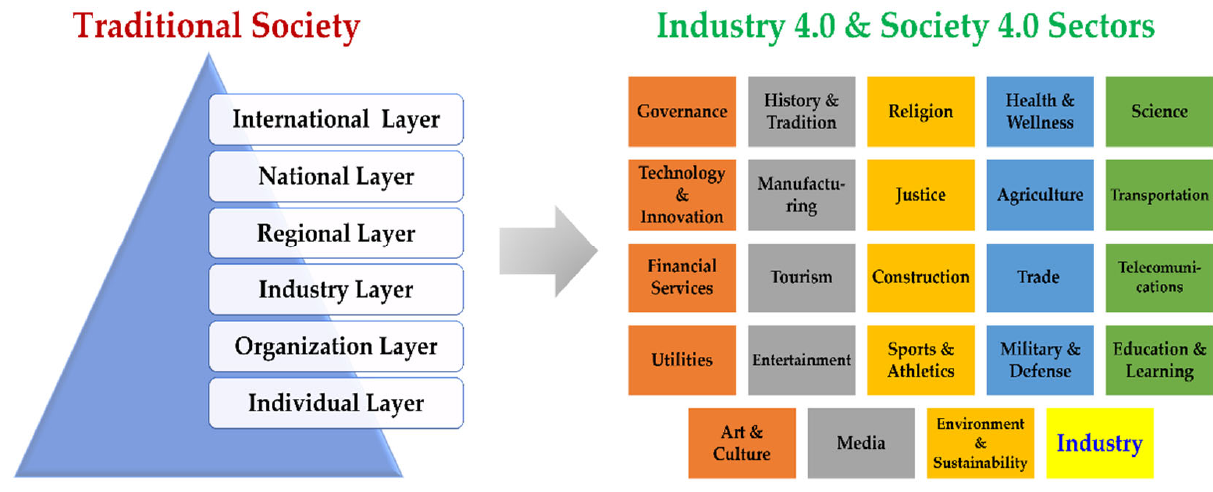
Figure 5. From Traditional Society to Society 4.0.